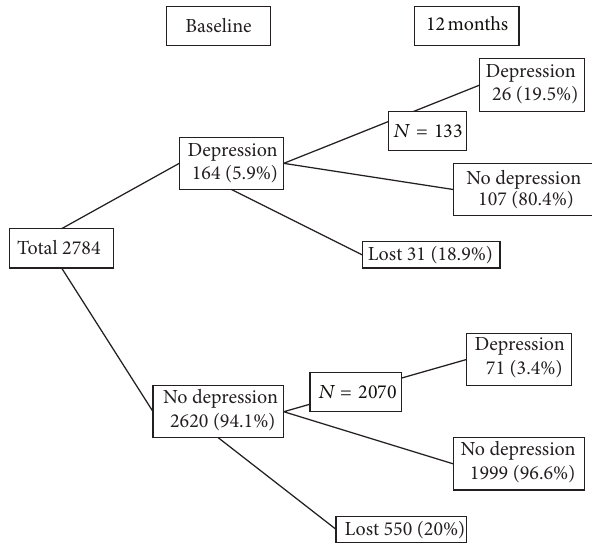
Figure 1: Depression patterns among the participants at baseline and the follow-up interview 12 months later ( 𝑛 = 2784